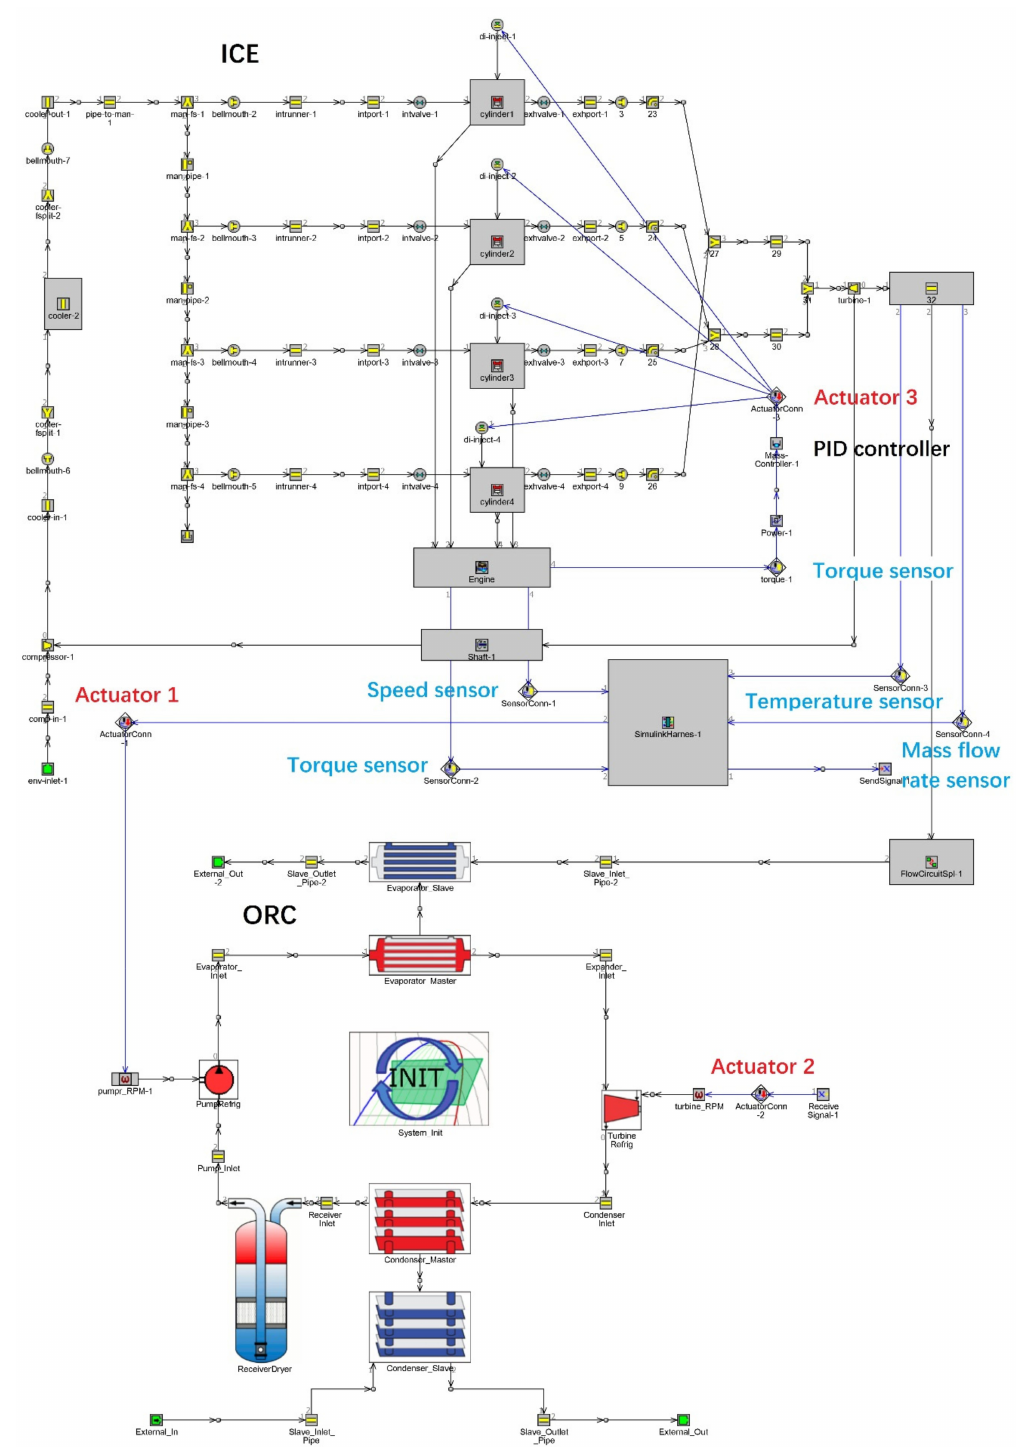
Figure 4. The ICE-ORC combined model in GT-POWER integrated with the control strategy designed in MATLAB /